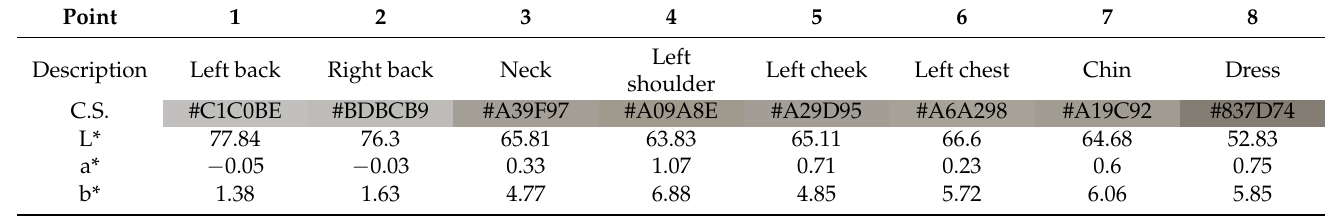
on the surface status. Under UV light, some fluorescent areas were